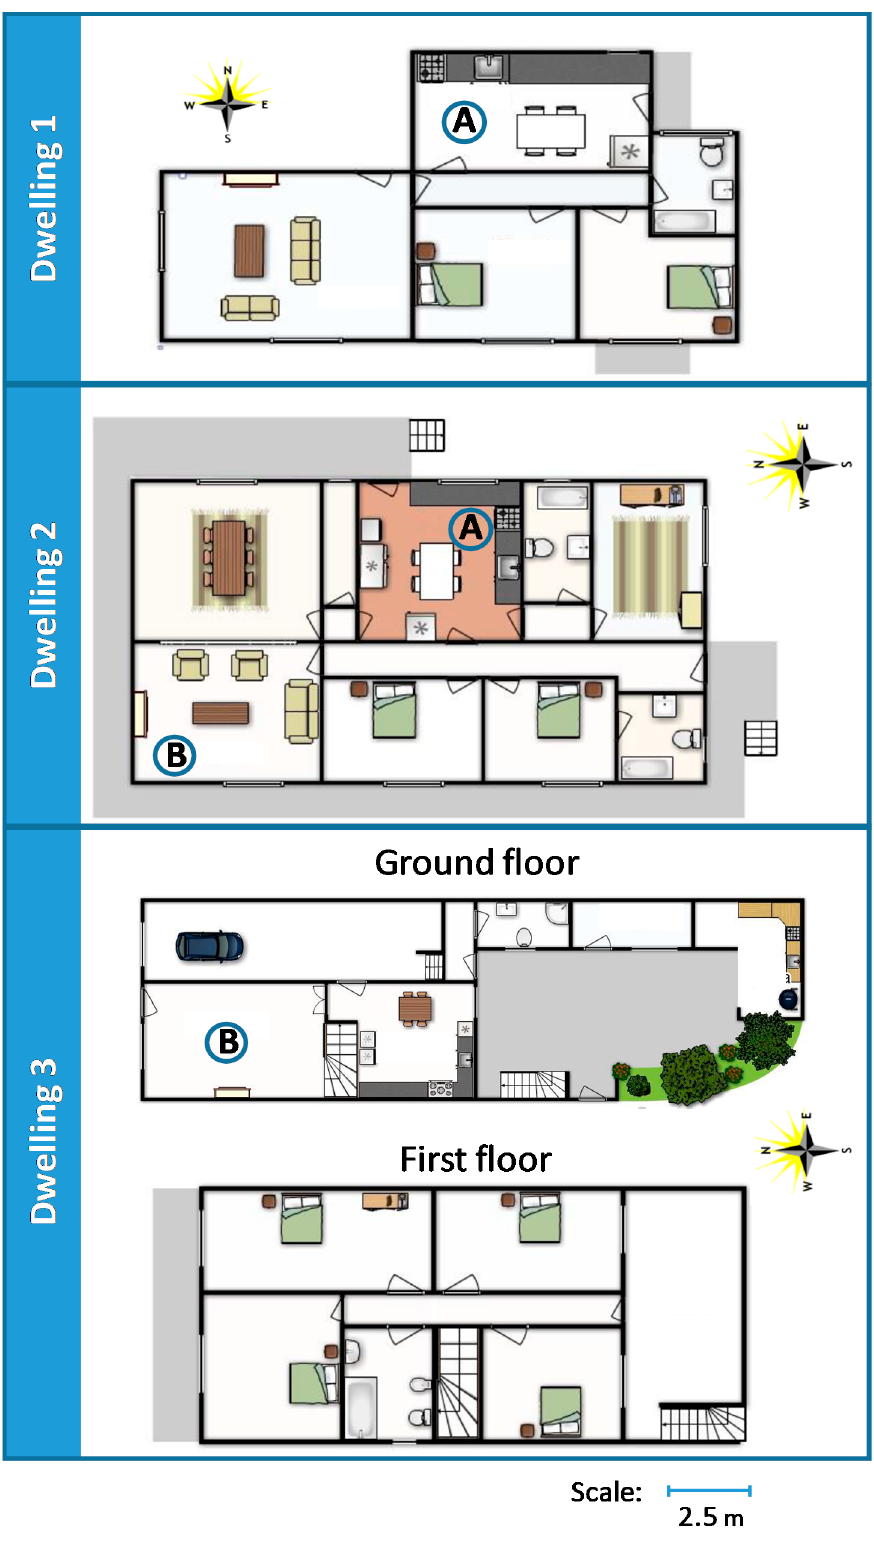
Figure 1. Floor plans of the studied dwellings with specification of the rooms where the monitoring was conducted: A—kitchen and B—living